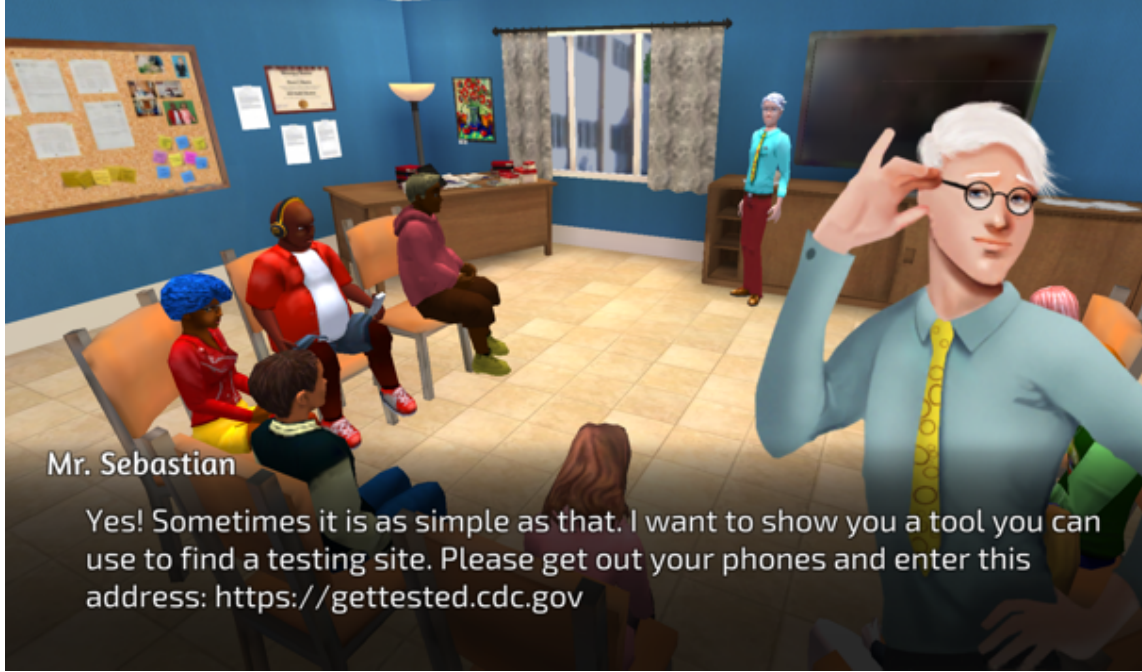
Figure 6. Screenshot of sex education class.